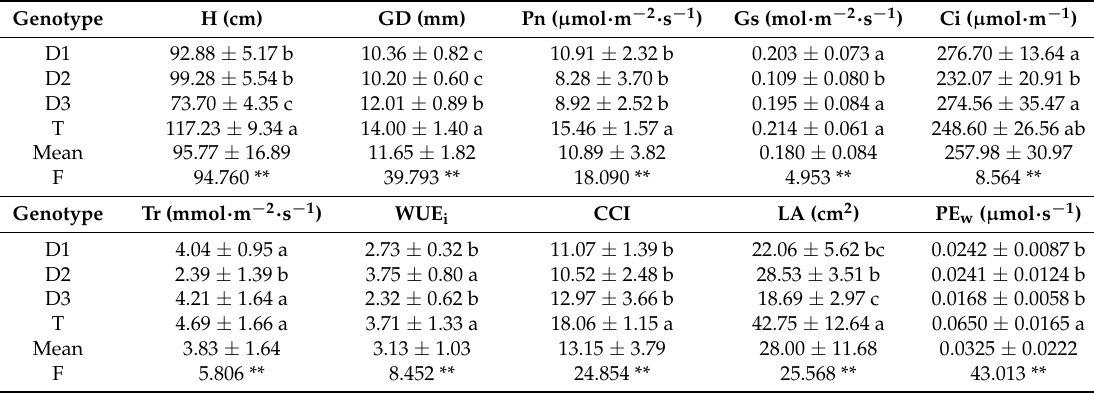
Table 6. Descriptive statistics (mean values ± SD) of ten quantitative traits measured from the top mature leaf of Eucalyptus urophylla at 6 months old.